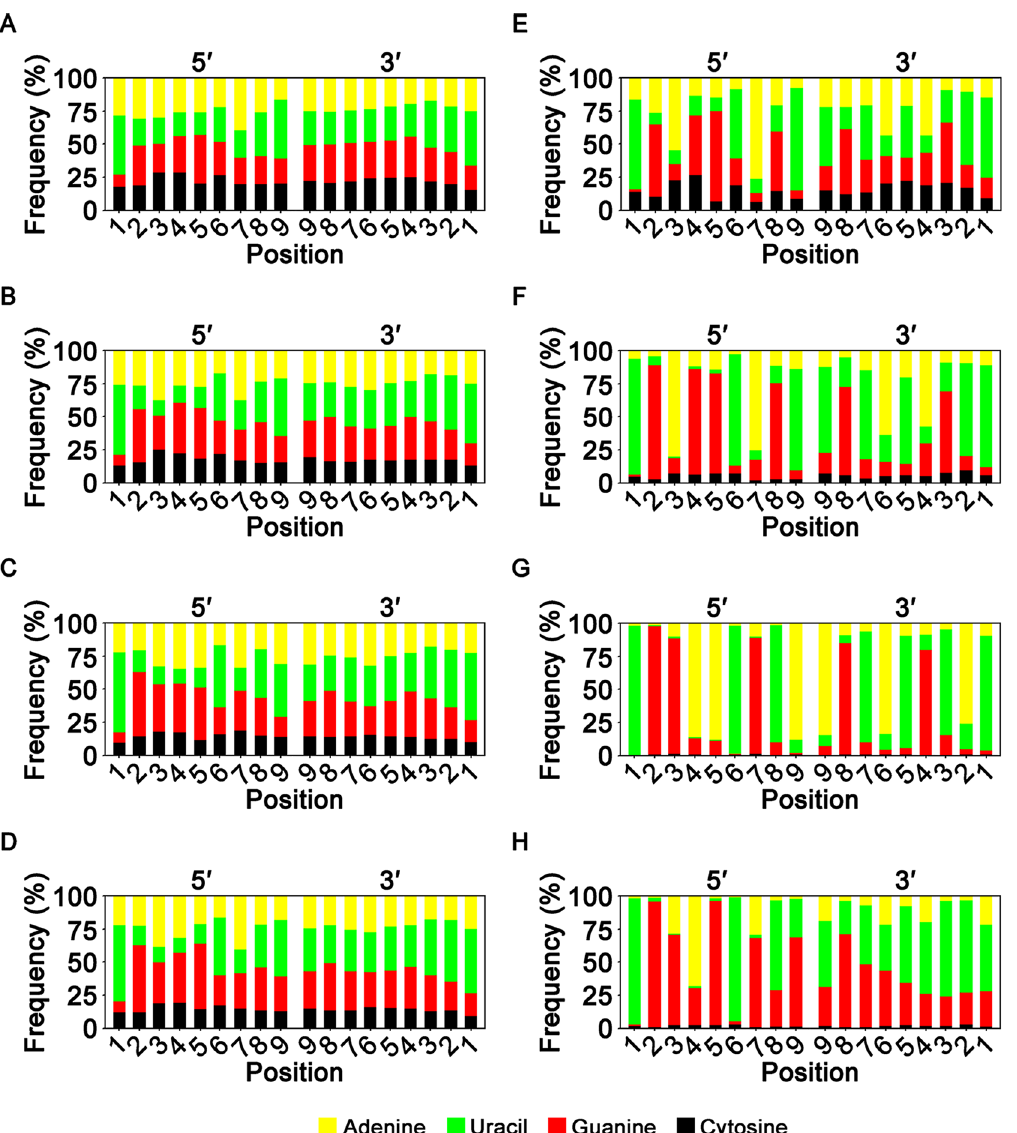
Fig 5. Position-dependent nucleotide composition for 5 0 - and 3 0 -ends of miRNAs. The composition was assessed in the expression-unweighted (A – D) and -weighted criteria (E – H), in plasma (A and E), colon (B and F), muscle (C and G), and liver (D and H). The x-axes represent nucleotide positions of miRNA sequences, and the y-axes the occurrence frequencies of nucleotides (n = 3 – 4).